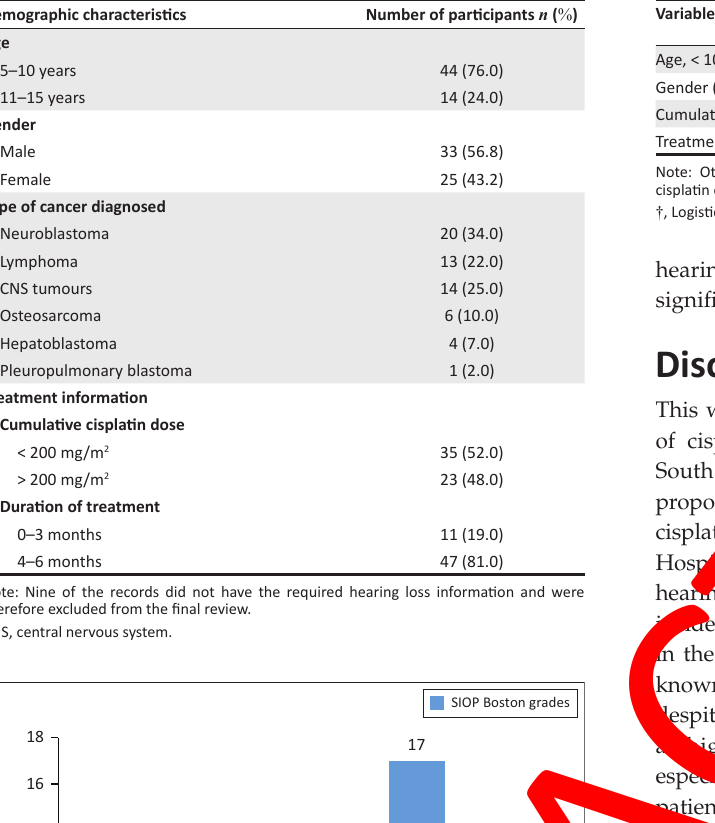
TABLE 2: Inferential statistics. TABLE 1: Participant demographic and treatment characteristics ( n = 58).